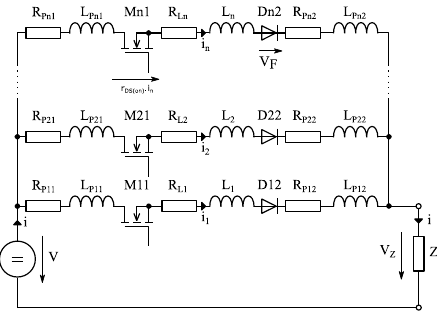
Figure 2. Substitute scheme for the first working period of the converter.